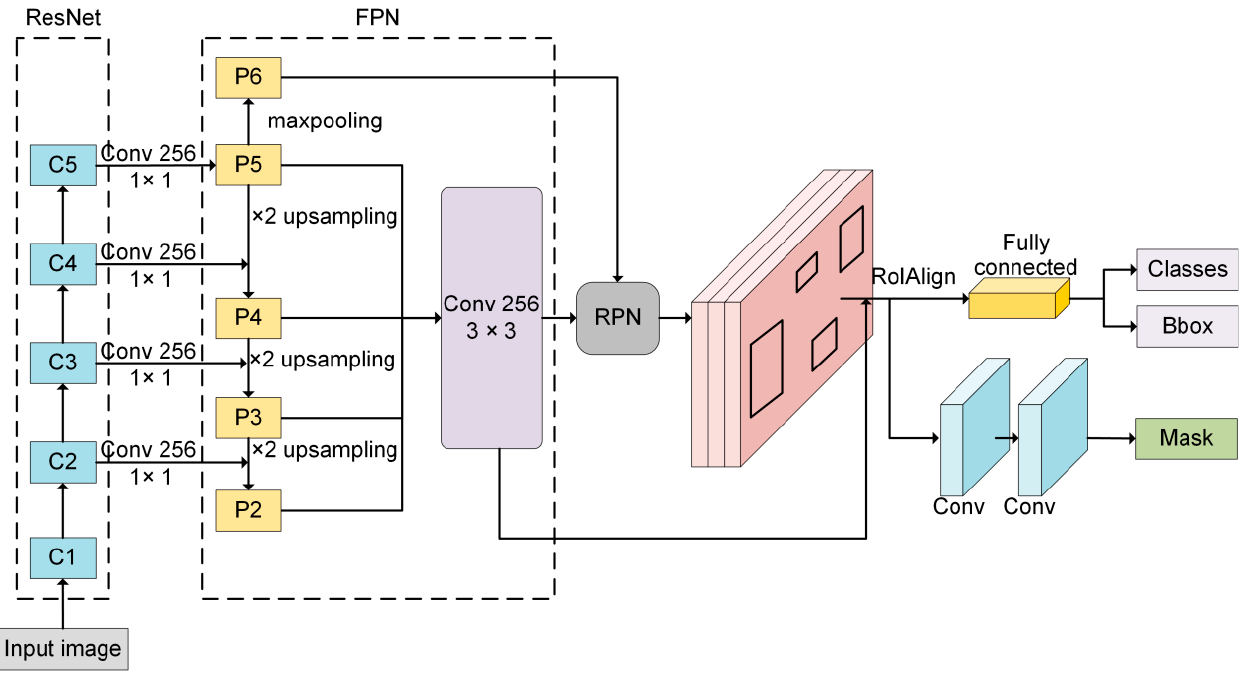
Figure 3. The framework of Mask R-CNN instance segmentation model. The loss function of Mask R-CNN consists of three components: classification error loss ( L cls ), bounding box regression error loss ( L box ), and mask segmentation error loss ( L mask ). The equations are as follows.